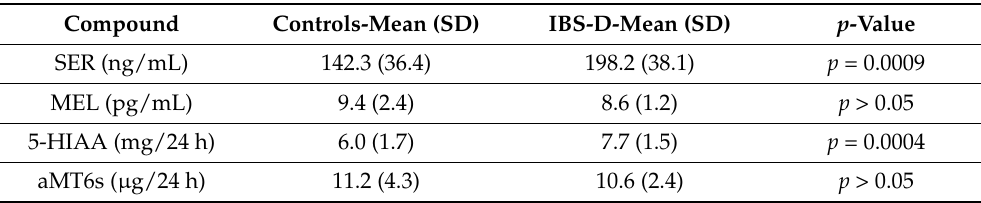
Table 2. Components of the serotonin pathway in healthy subjects (Controls) and in patients with diarrhea—predominant irritable bowel syndrome (IBS-D).